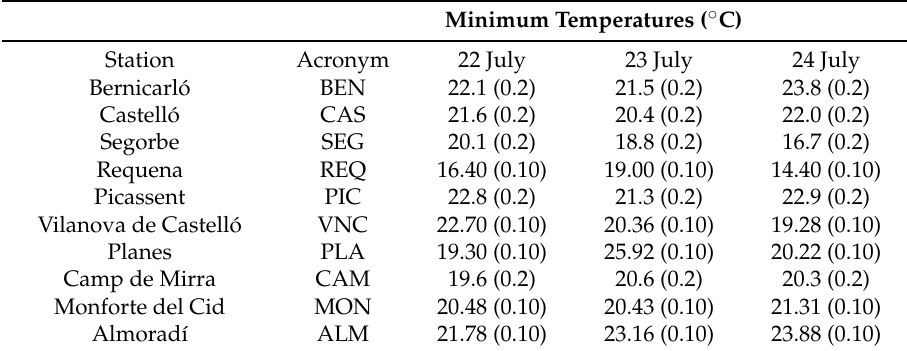
Table 3. Same as Table 2, but considering the observed minimum temperatures ( ˝ C).